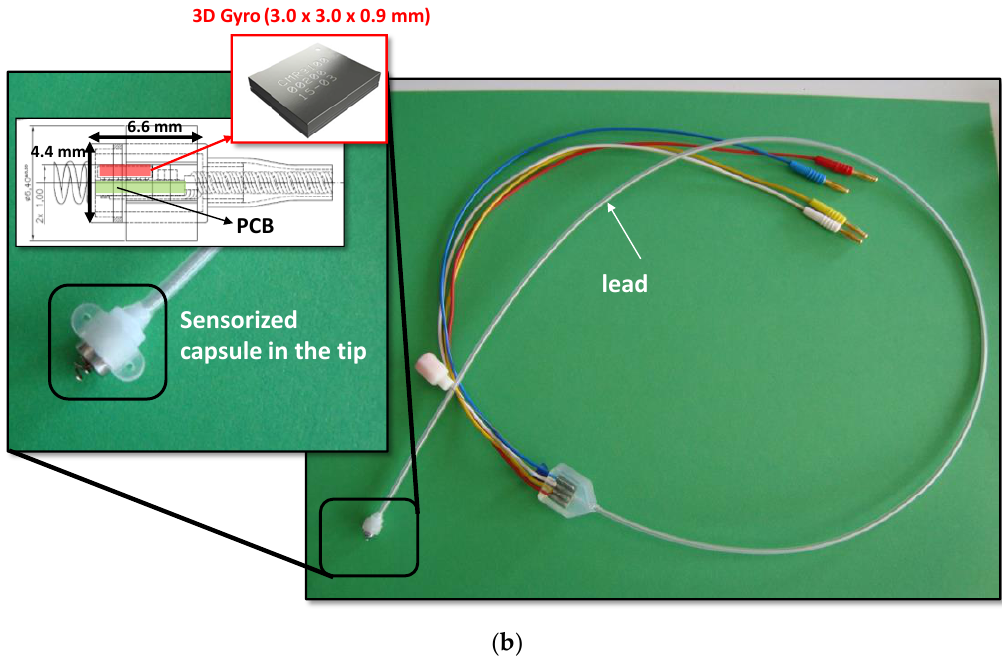
Figure 2. The CardioMon lead: ( a ) 3D rendering of the CardioMon lead design; ( b ) picture of the assembled CardioMon prototype.